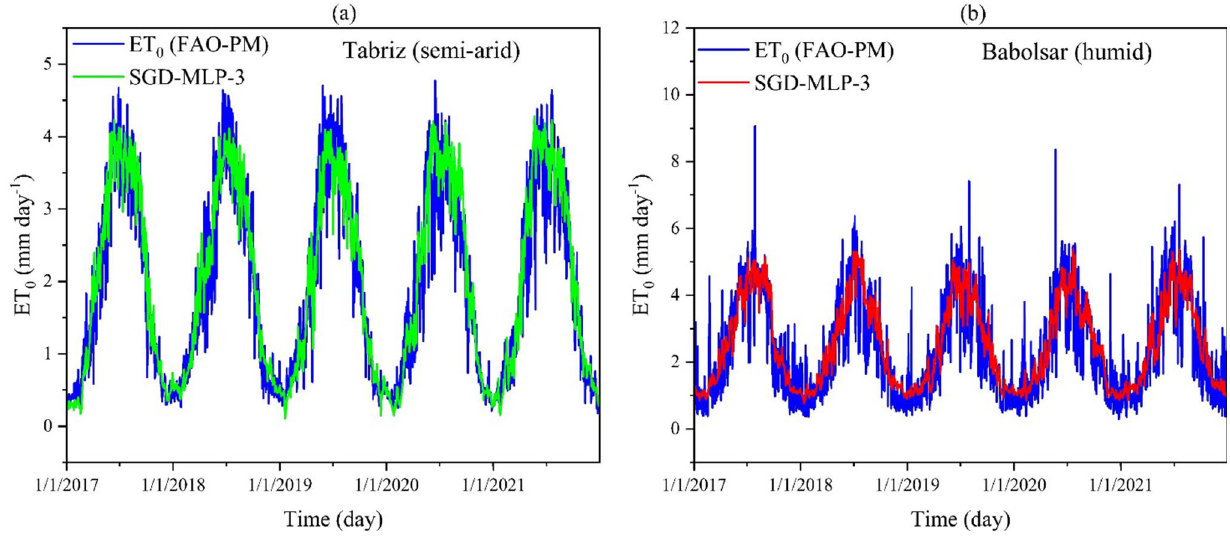
Fig. 7 Evaluation of best algorithms SGD-MLP-3 (for Model-3) at Tabriz (semi-arid climate) and Babolsar (humid climate)